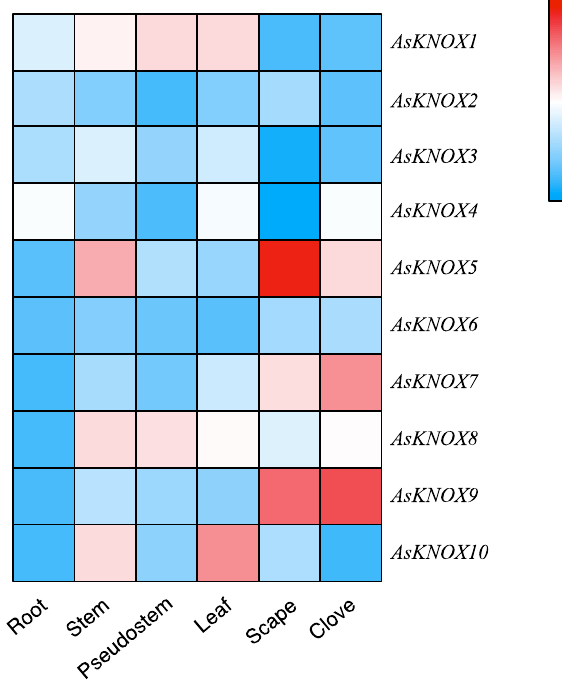
Figure 6. Expression analysis of AsKNOX genes in different garlic tissues. The color scale from blue to red represents the lower to higher relative expression levels.